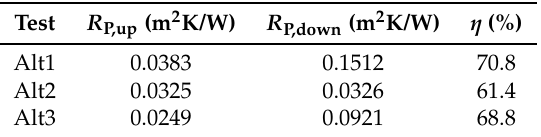
Table 9. Calculation results of upper and lower thermal resistances of the sample panel and their efficiency (additional